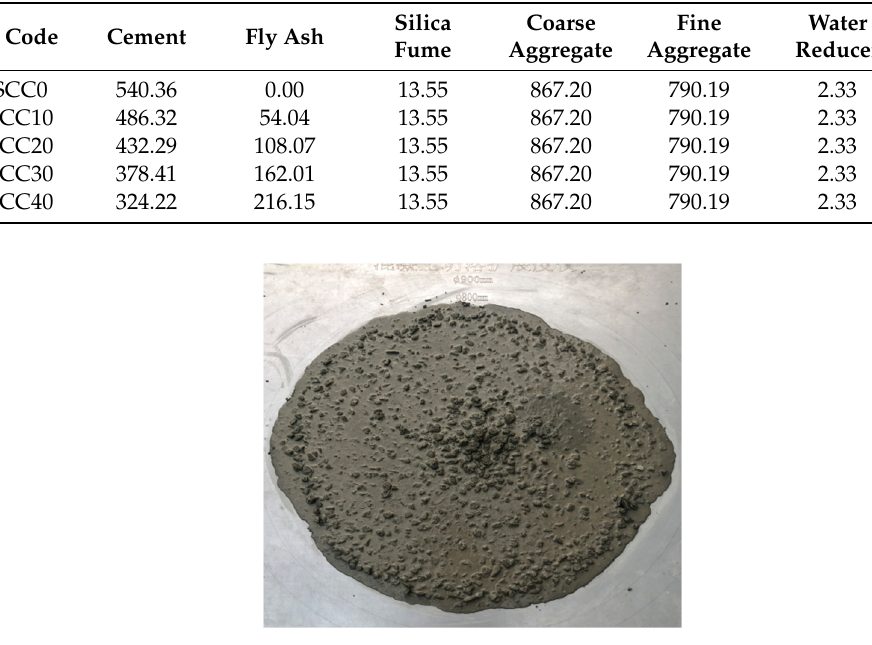
Figure 5. The extending properties of self-compacting concrete (SCC).